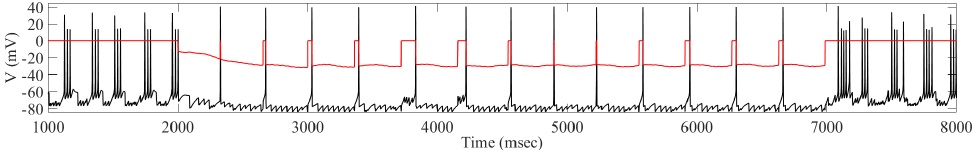
Figure 9. STN 1 membrane potential (black) with corresponding stimulation received (red) with parameters a 0 = 10 and interspike time threshold parameter intt = 325 ms. Note that the top part of the red curve represents the time when the stimulation is turned off, while the bottom part of the curve is when the stimulation is turned on.